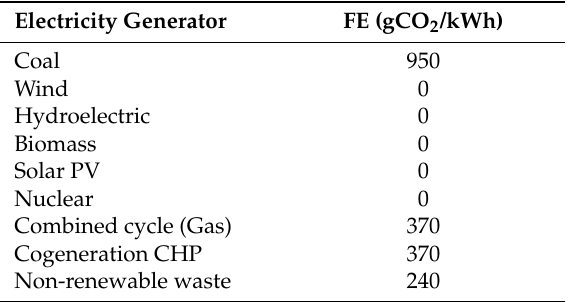
Table 8. CO 2 emission factor (FE) by type of electricity